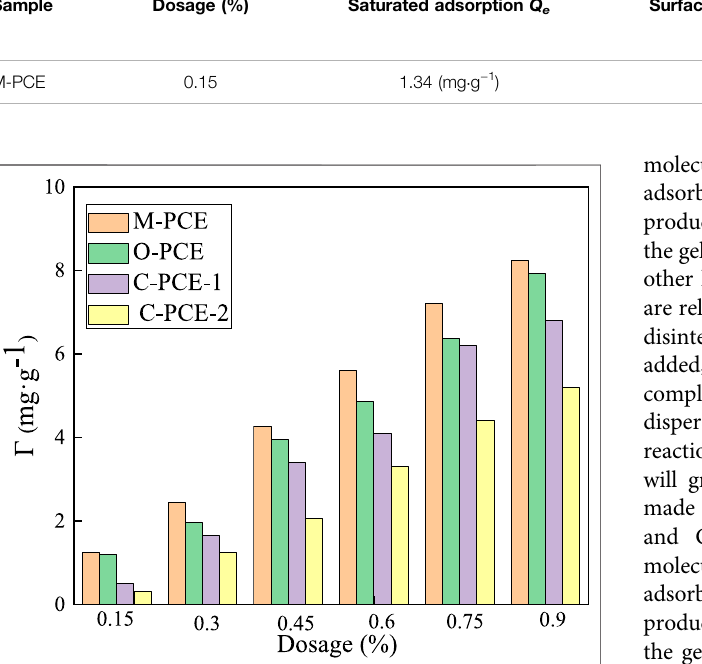
TABLE 4 | Basic performance of M-PCE. Sample